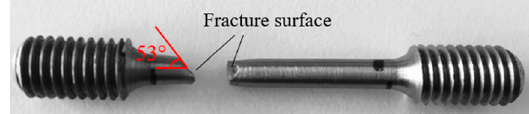
Figure 20. Tensile test sample out of AISI 4340 after testing.